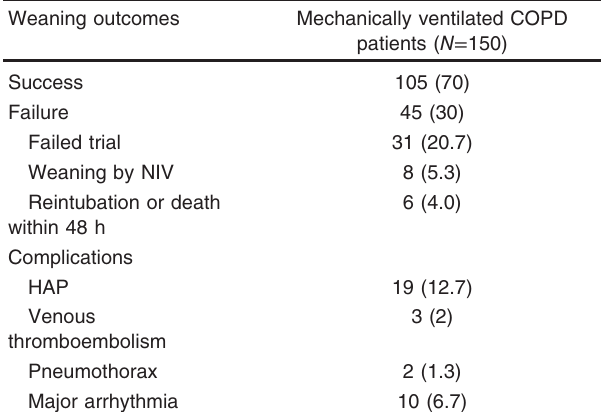
Table 2 Outcome of spontaneous breathing trial and occurrence of complications (150 mechanically ventilated chronic obstructive pulmonary disease patients)